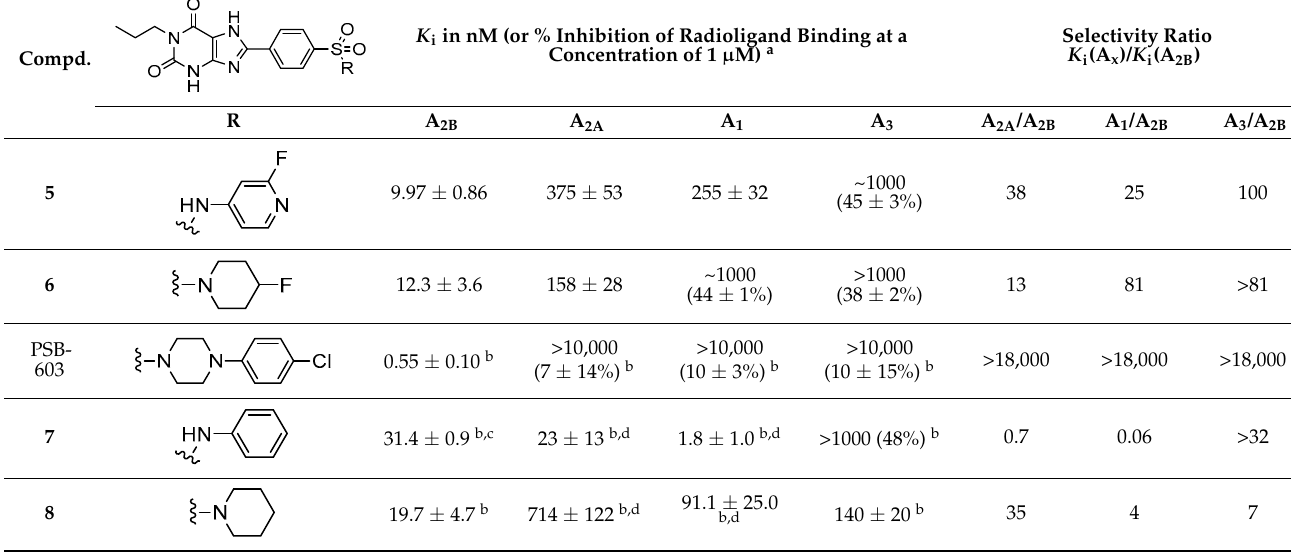
a Data represent mean values ± SEM of three independent experiments that were performed on human receptors unless otherwise noted. Competition binding assays with [ 3 H]PSB-603 (A 2B ), [ 3 H]MSX-2 (A 2A ), [ 3 H]CCPA (A 1 ), and [ 3 H]PSB-11 (A 3 ) as radioligands and membranes were obtained from CHO cells stably expressing the corresponding human adenosine receptor. b Data are taken from [13,23,37]. c Determined with [ 3 H]PSB-298. d Receptor binding determined with adenosine- receptor-expressing rat brain cortical membranes.